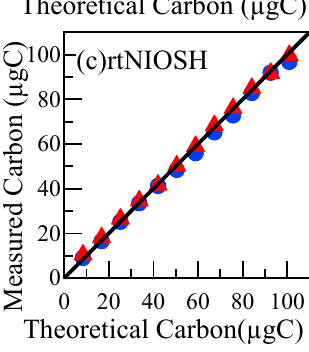
Figure 1. Sucrose calibration results of (a) IMPshort (b) IMPlong and (c) rtNIOSH protocols, baseline corrected with MP and SP, respectively. The 1:1 line was shown for reference. Linear regression of TC MP was indicated in blue line for reference.